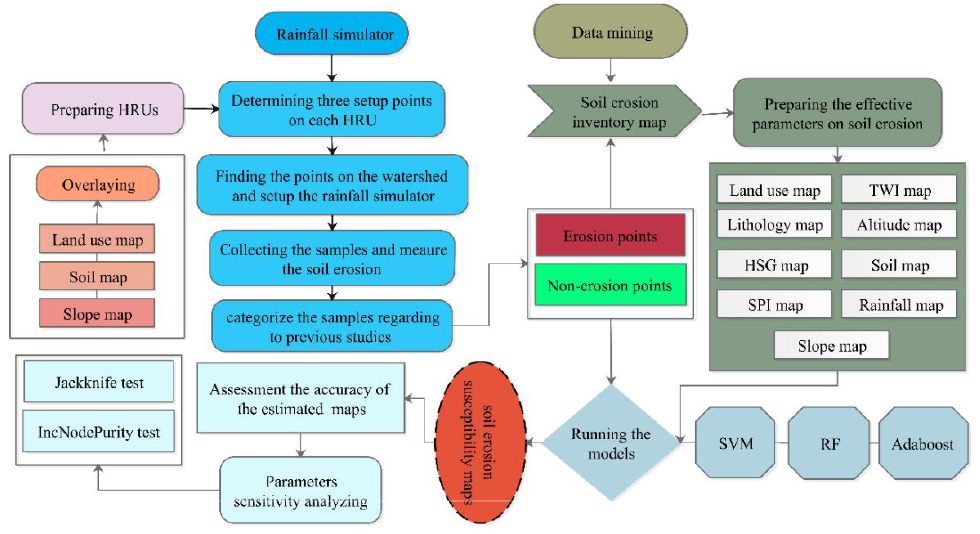
Figure 2. Flowchart outlining the methodology utilized to prepare soil erosion susceptibility map.